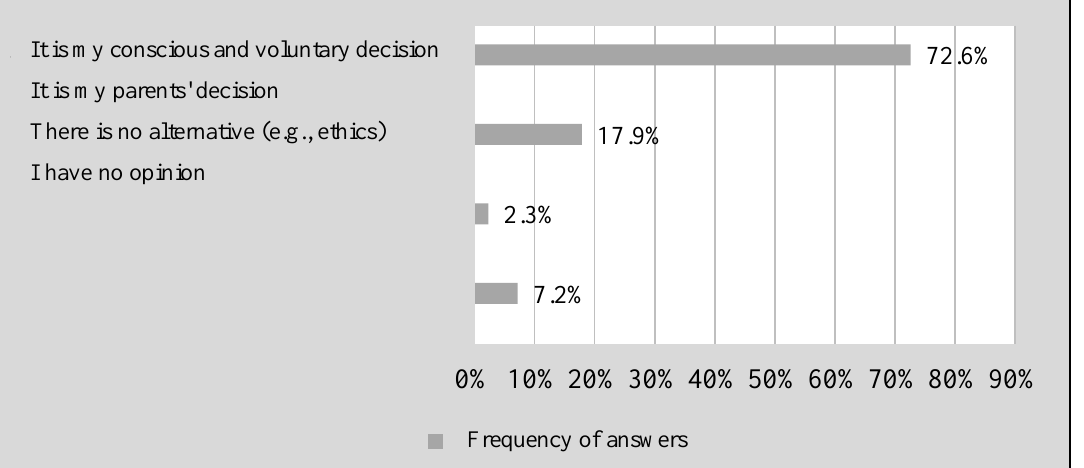
Figure 1. Why do you attend religious education classes? (Source: own study).